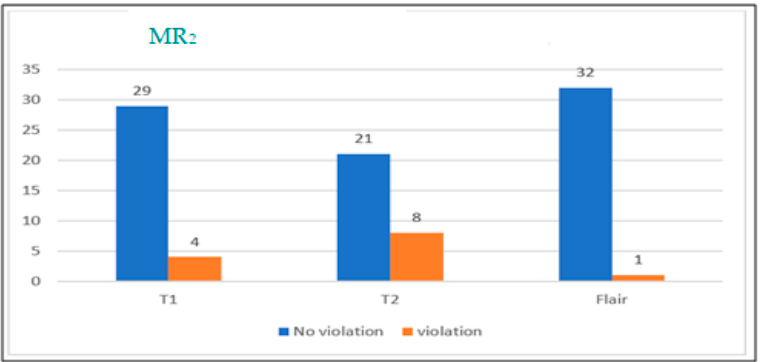
Figure 8. No. of test cases violating MR 2 for T1, T2, and flair images.